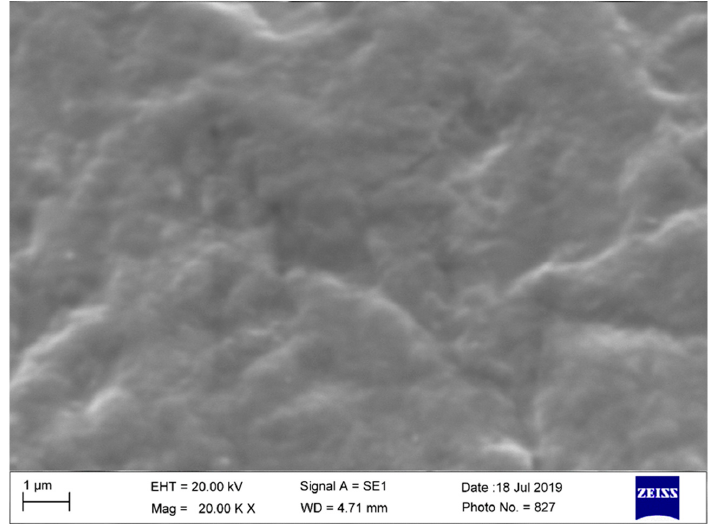
Figure 12. SEM analysis composition of the used drills.